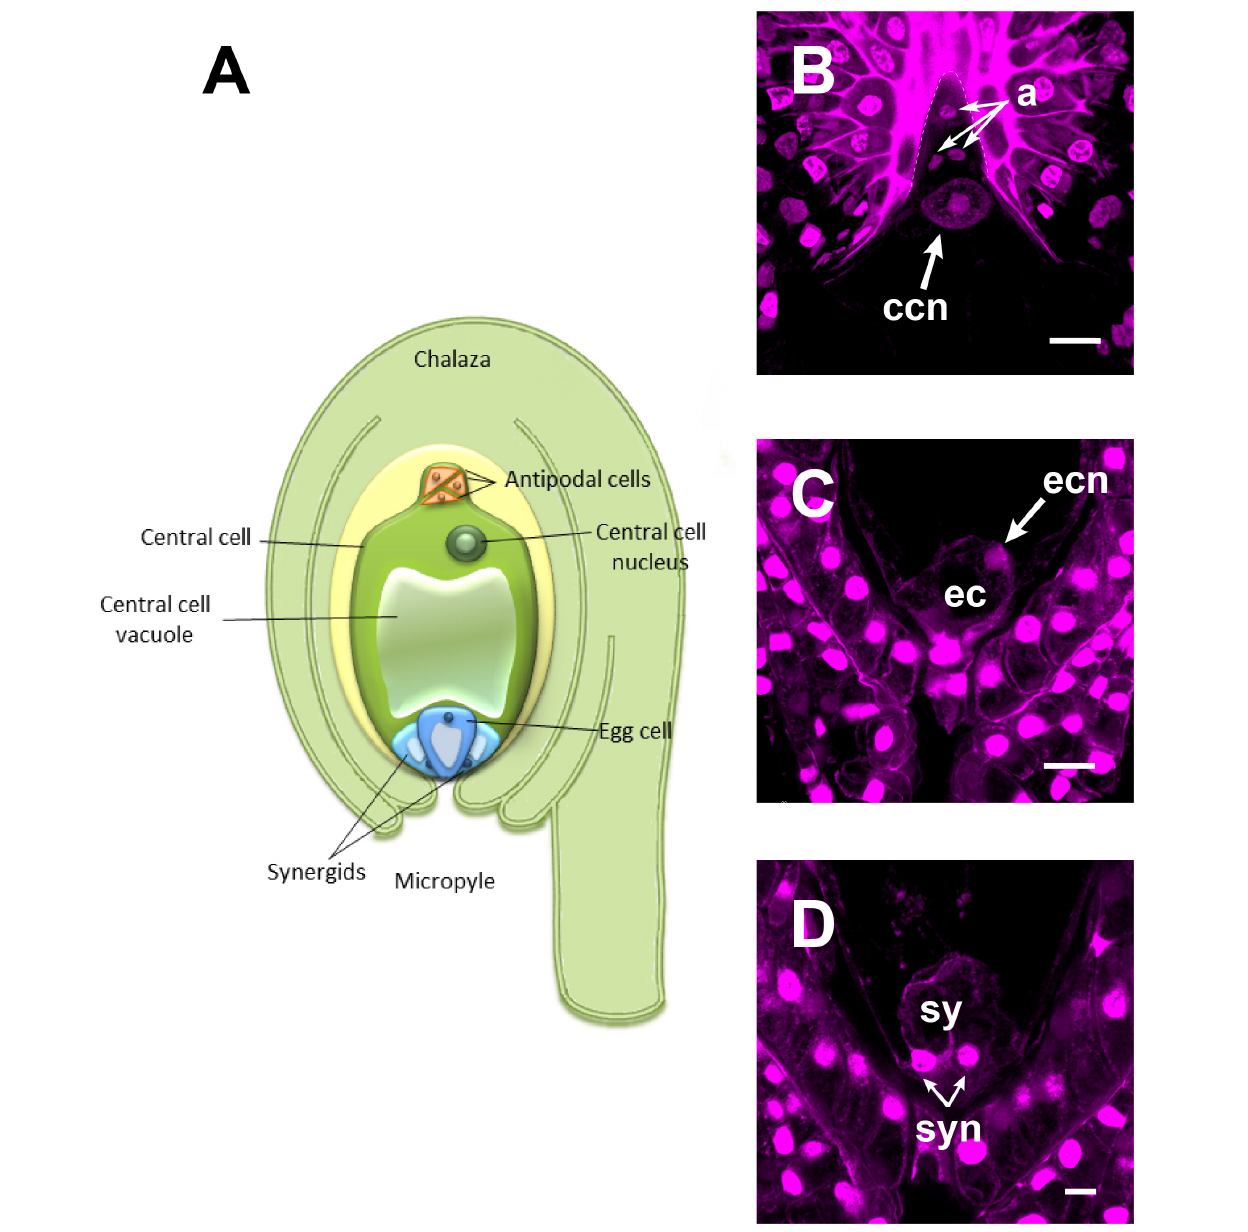
FIGURE 1 | The mature female gametophyte of Agave inaequidens (time “0”). (A) Scheme of a seven-celled embryo sac arranged in four cell types: three antipodal cells, placed just below the hypostase, and a large central cell with its nucleus polarized toward the chalaza (B) . At the micropylar end, the egg apparatus is composed of an egg cell (C) and two synergids (D) . (B–D) Are Feulgen-stained z-stack images. a, antipodal cells; ccn, central cell nucleus; ec, egg cell; ecn, egg cell nucleus; sy, synergids; syn, synergids nuclei. Bar in (B,C) = 20 µ m and (D) = 10 µ